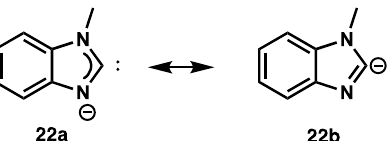
Figure 4. Possible carbenic ( 22a ) and carbanionic ( 22b ) resonance contributors for the N,NR ligand moiety in complex 17 .